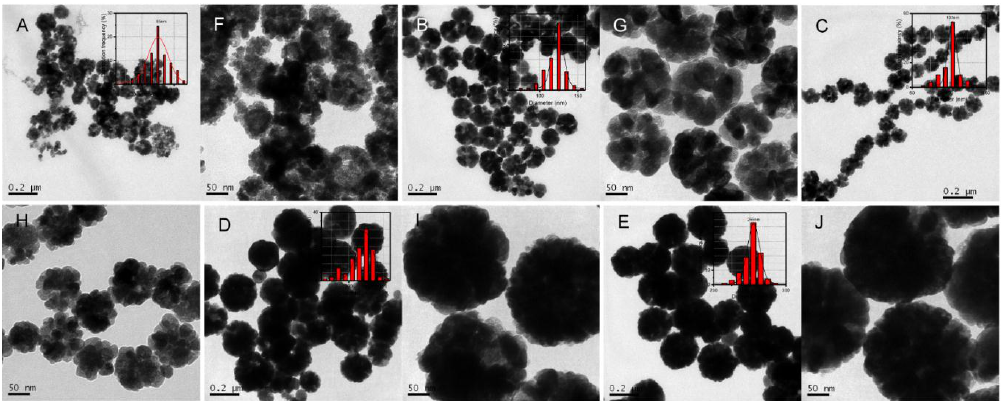
Figure 6. TEM images and size analysis patterns of Fe 3 O 4 with different molar ratio of NaAc, ( A ) 5 mmol; ( B ) 10 mmol; ( C ) 20 mmol; ( D ) 40 mmol; ( E ) 60 mmol, the insets are the corresponding